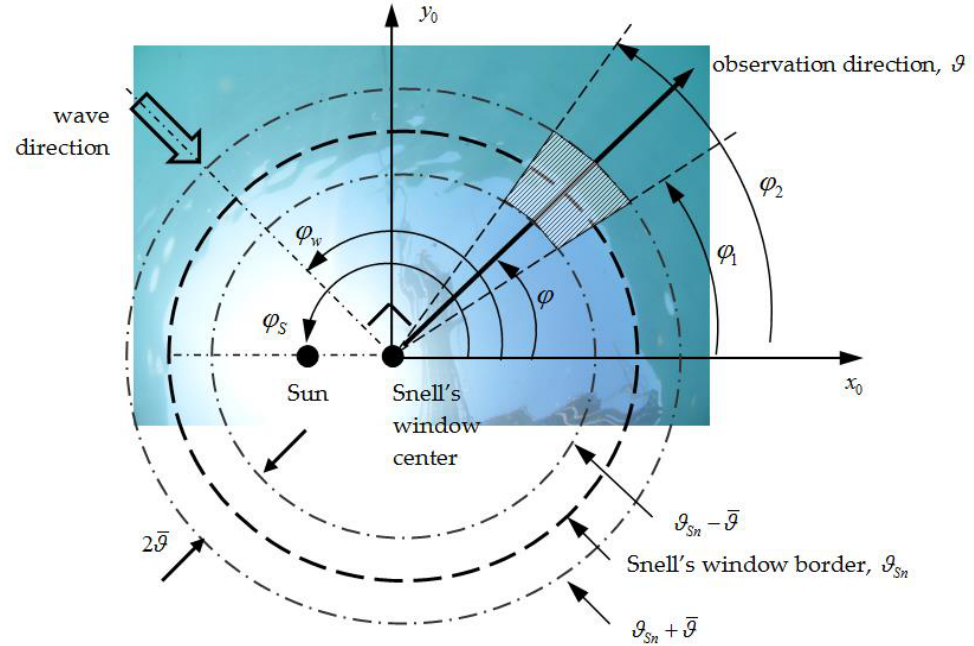
Figure 5. Determination of the optimal radial section of the Snell ’ s window image.